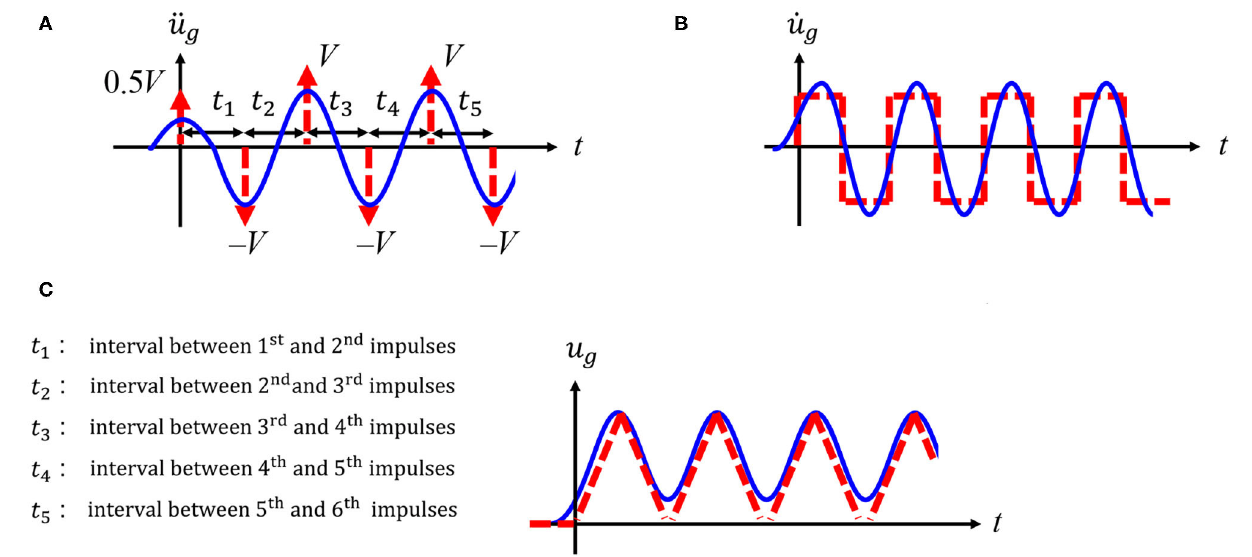
FIGURE 1 | Multi impulse and corresponding sinusoidal wave. (A) Acceleration. (B) Velocity. (C) Displacement.